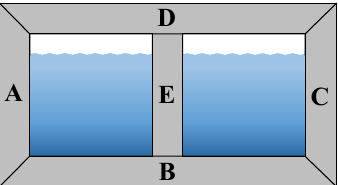
Figure 5. Culvert damage simulation distribution map.